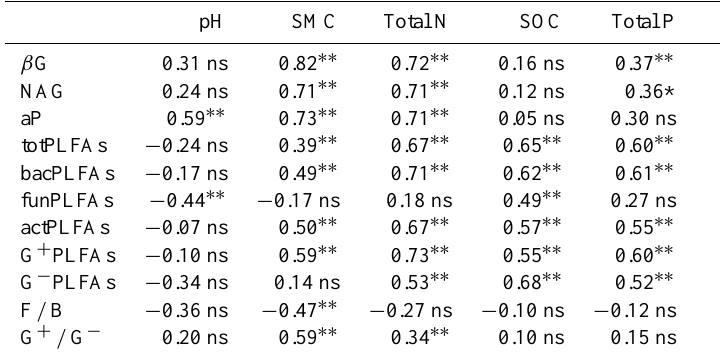
Table 2. Pearson correlations between soil properties, soil enzyme activities and microbial variables. pH